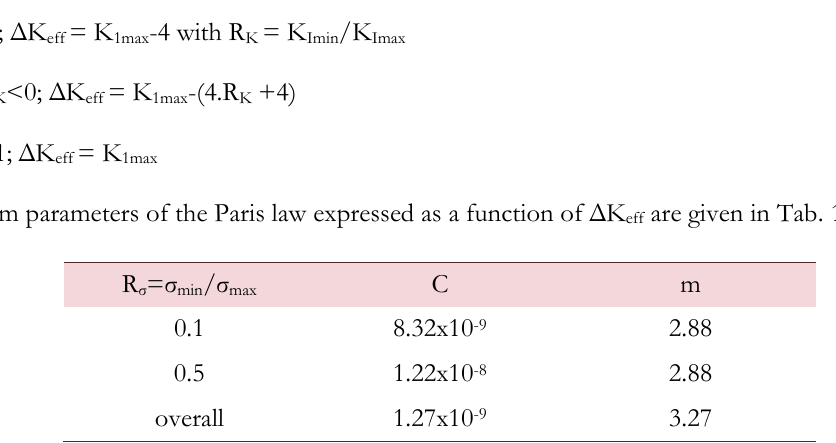
Table 1: Crack propagation laws from british standard BS7910-05